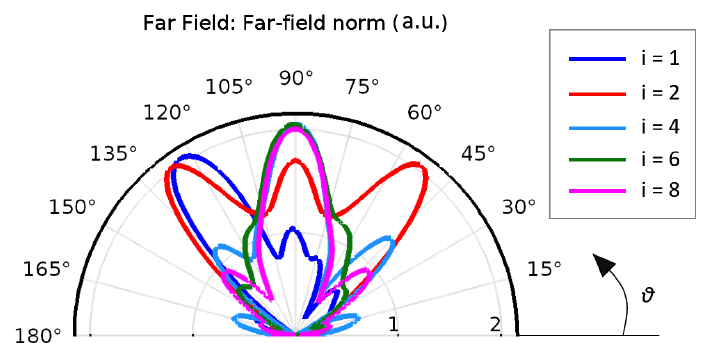
Figure 4. The second harmonic radiation pattern for the considered cases of optimized plane wave 209 excitation. 210